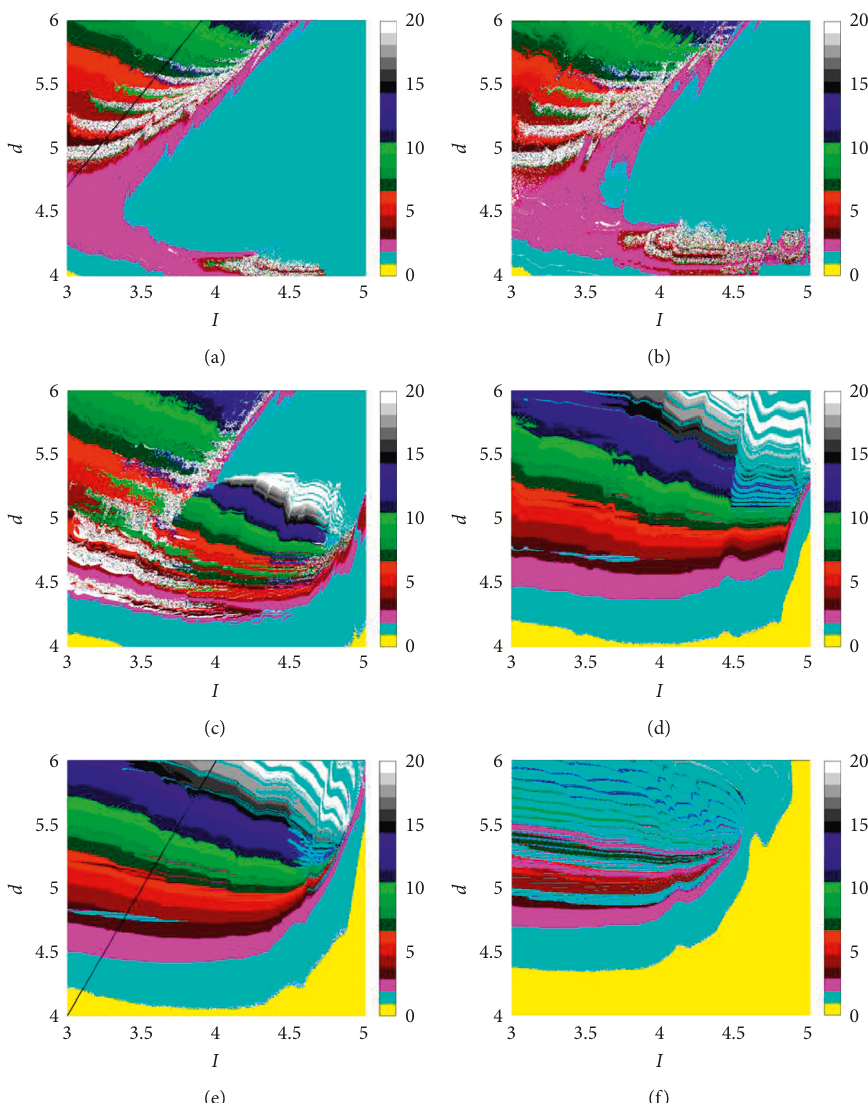
Figure 4: Two-parameter bifurcation diagrams of the coupled model with I ∈ [ 3 , 5 ] and d ∈ [ 4 , 6 ] . For (a) D � 3, τ � 0 . 01; (b) D � 5, τ � 0 . 01; (c) D � 3, τ � 0 . 05; (d) D � 5, τ � 0 . 05; (e) D � 3, τ � 0 . 1; and (f) D � 5, τ � 0 . 1. Different colors are used to draw different firing states of the membrane voltage, and corresponding numbers are marked in the color bar on the right side of the figure. The initial values are selected with (0.1, 0.01, 1.05, 0.1, 0.01,